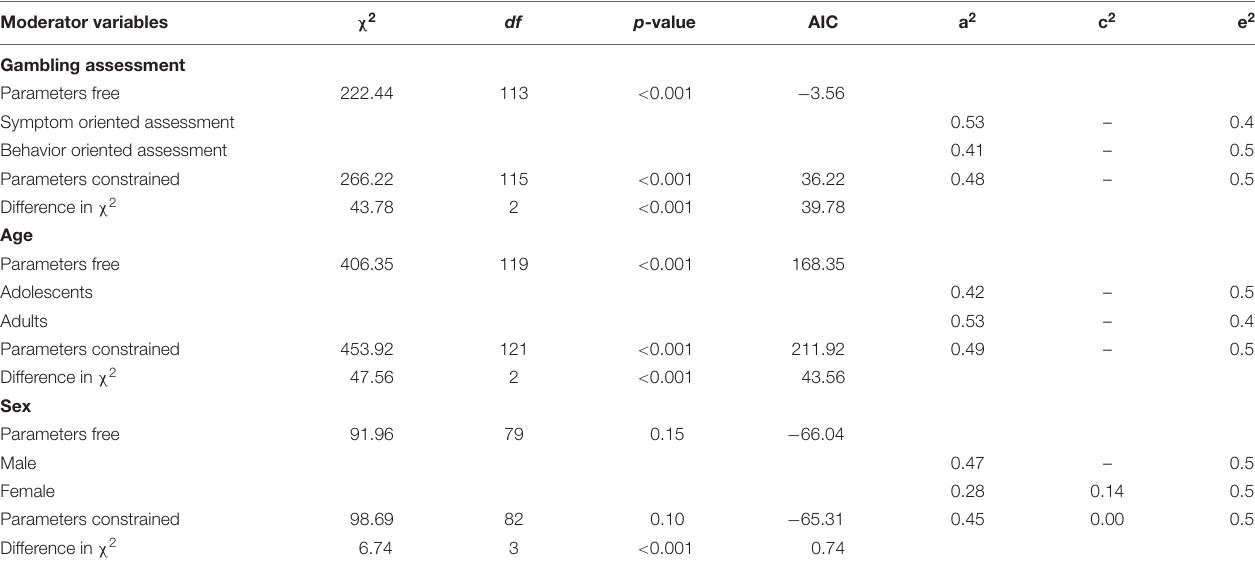
TABLE 2 | Standardized parameter estimates and fit statistics for the best fitting models in the moderation effect